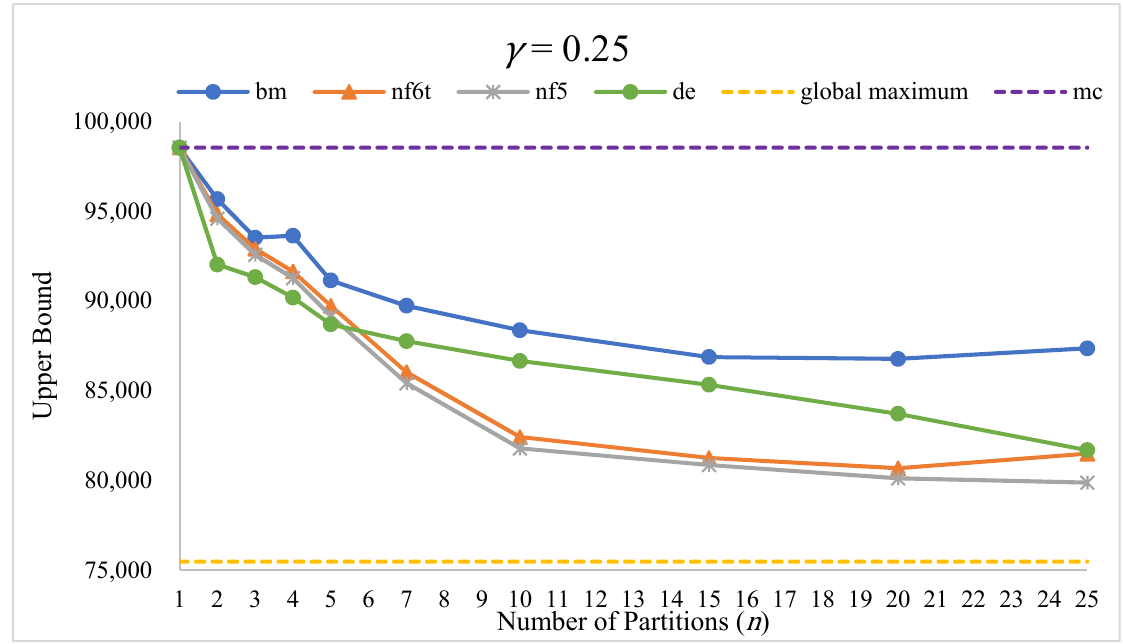
Figure 4. Convergence-indicating curves of the bm , de , nf5 , and nf6t relaxation schemes for γ =